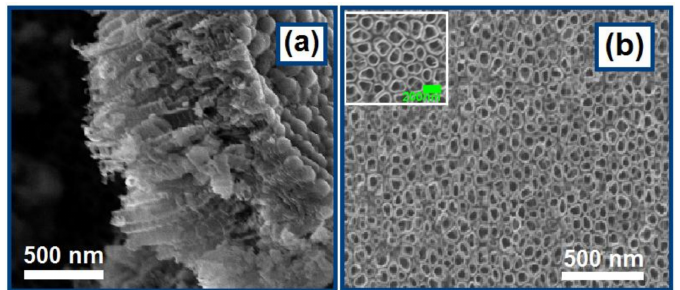
Figure 1. Field-emission scanning electron microscopy (FESEM) images of the titanium dioxide nanotube arrays (TNTAs) prepared by electrochemical anodization of Ti foil: ( a ) cross-section and ( b ) top